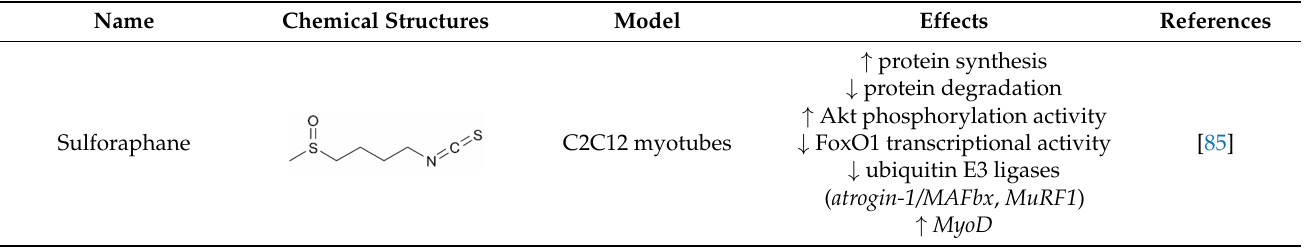
Table 4. The role of minerals in glucocorticoid-induced muscle